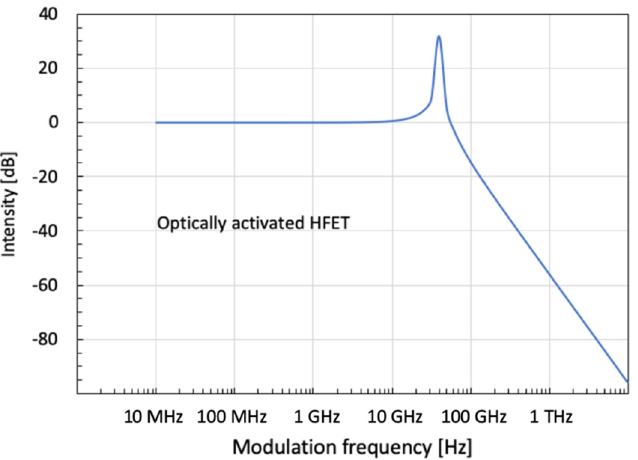
Figure 6. Simulated frequency response of a GaN/AlN-based SL detector used as gate region of an HFET showing a low-pass filter characteristic with a 3 dB frequency of 80 GHz. This simulation was made using ‘ LTspice XVII for OS X’ (www.analog.com (accessed on 31 August 2021) and LTspice@analog.com).